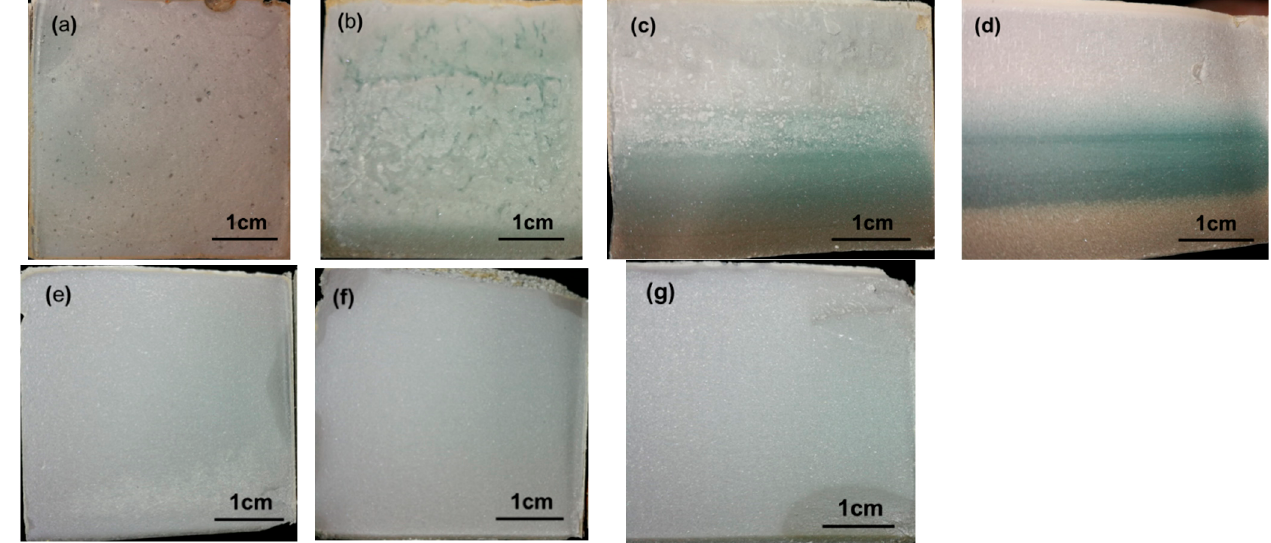
Figure 14. Failure section characteristics of the 28-day of CEM III/B MCG stone with various SP and W/S of 1.0 ( a ) 0.5%N ( b ) 1.0%N ( c ) 1.5%N ( d ) 2.0%N ( e ) 0.5%PCE ( f ) 1.0%PCE ( g ) 1.5%PCE.